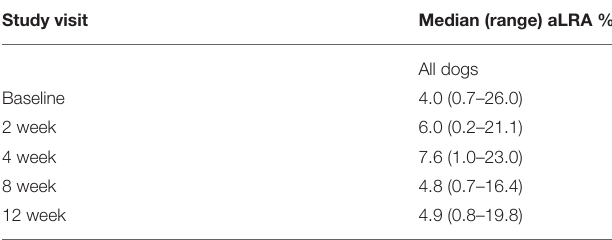
aLRA, absolute left right asymmetry between left and right pelvic limbs.